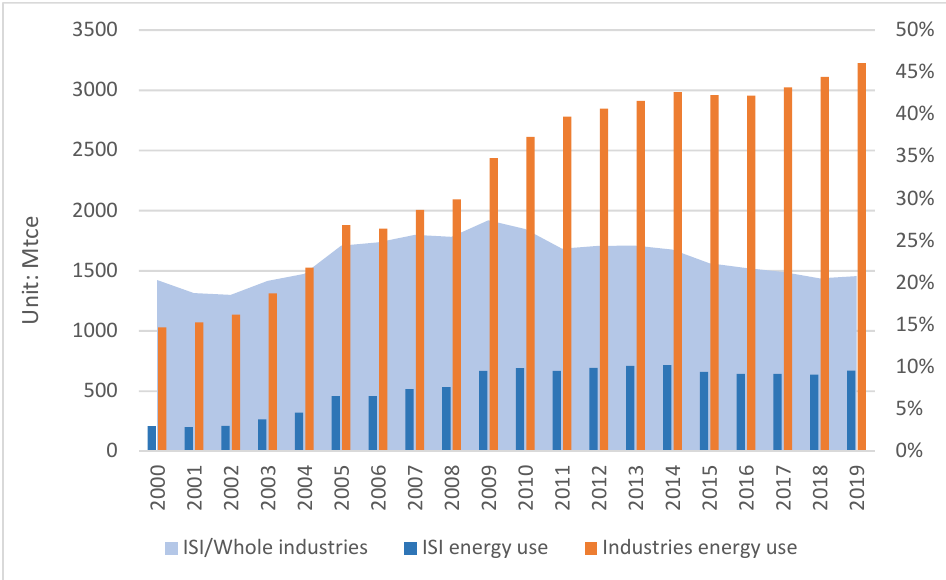
Figure 2. Energy use in China’s ISI and its proportion in whole industries. Source: China Statistical Yearbook, 2001–2020.